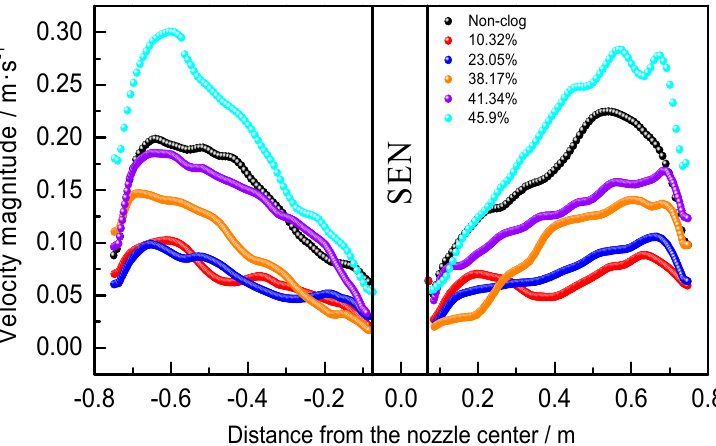
Figure 12. Time-averaged velocity magnitude in the steel–slag interface.